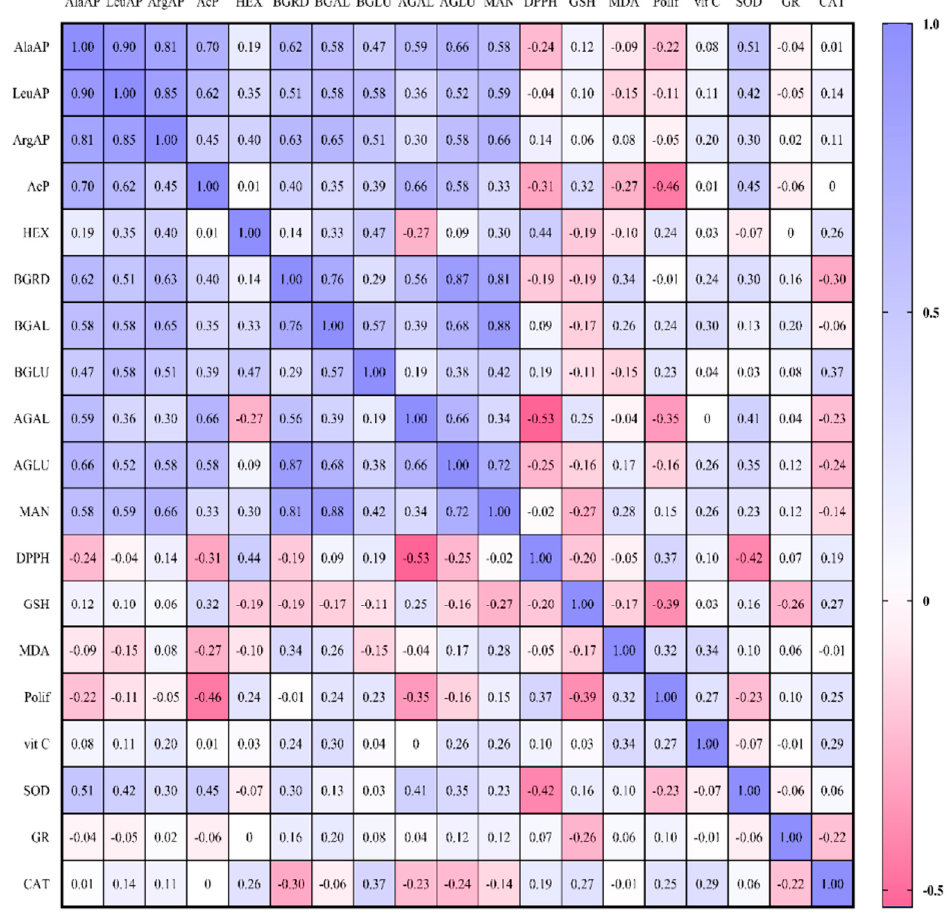
Figure 1 . Significant Pearson correlation ( p < 0.01) and ( p < 0.05) between feeding system . Figure 1. Significant Pearson correlation ( p < 0.01) and ( p < 0.05) between feeding